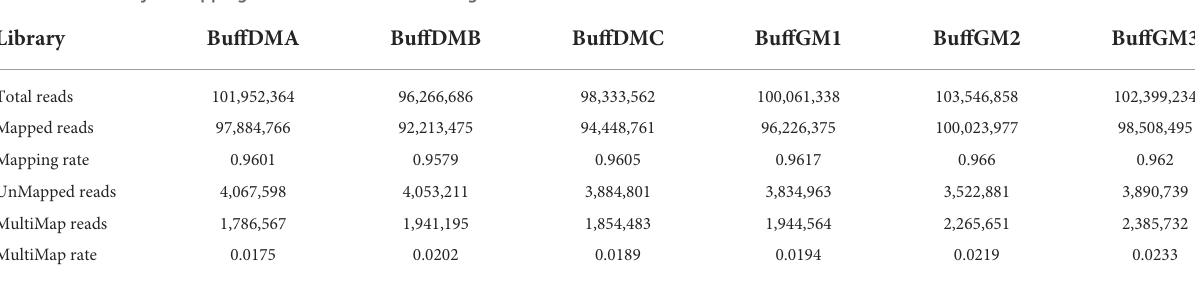
TABLE 1 Summary of mapping the reads to the reference